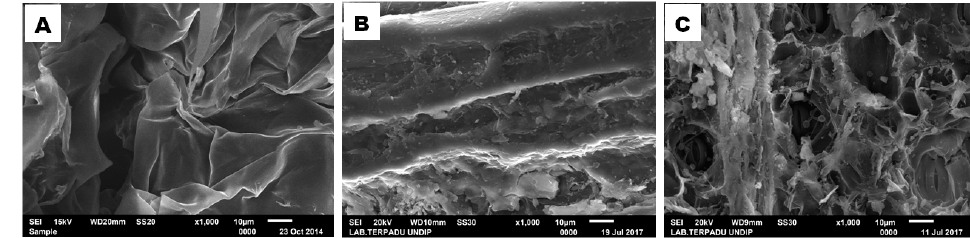
Figure 11. Comparison of 1000X SEM EDX of: ( A ). Coco-husk; ( B ). Hemp; ( C ) Kenaf.